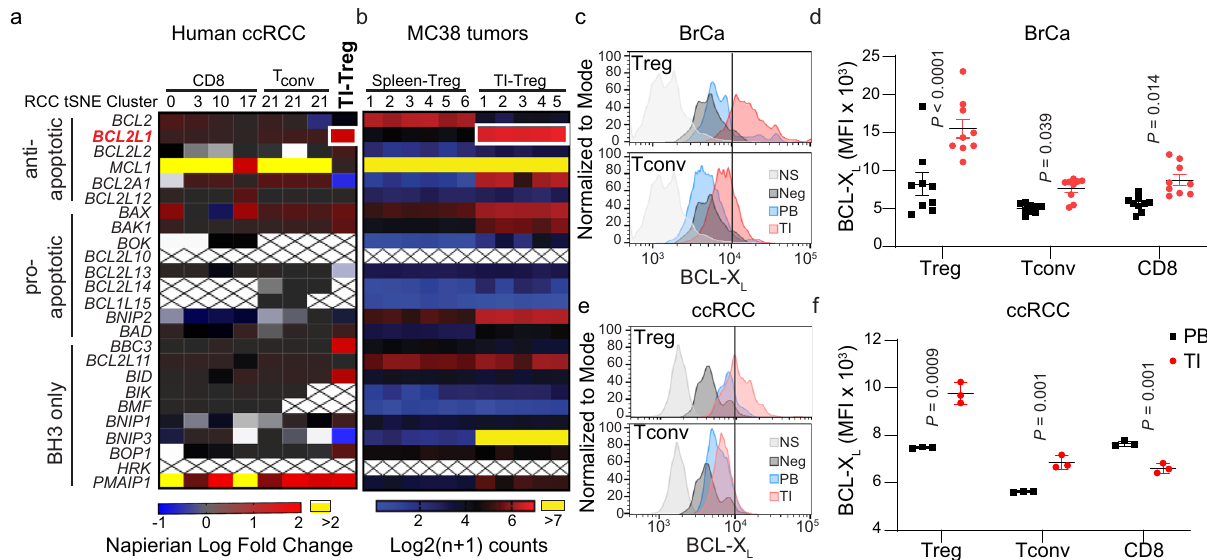
Fig. 1 BCL-X L is selectively upregulated in TI-Tregs. a Heatmap depicting the fold difference in expression of members of the BCL-2 gene family from distinct subsets of TI-T cells relative to T cell counterparts from peripheral bloods (PB) of paired RCC patients. TI-T cells include CD8 + , conventional CD4 + (Tconv), and TI-Tregs. See Supplementary Fig. 1a for characterization of immune cell clusters by tSNE plot of scRNAseq data. Cross-hatching indicates no expression. b Heatmap depicting the expression of BCL-2 family genes in mouse MC38 colon adenocarcinoma TI-Tregs and splenic Tregs. c Representative histogram showing BCL-X L levels in PB- and TI-Tregs or TI-Tconv from human breast cancer (BrCa), and d median fl uorescence intensity (MFI) of BCL-X L staining ± s.d. in PB- or TI-Tregs, CD8 + , and Tconv in these cancers ( n = 9 biological replicates). e Representative histogram showing BCL-X L levels in PB- and TI-Tregs or TI- Tconv from human renal cancer and paired blood, and f MFI of BCL-X L staining ± s.d. in PB- or TI-Tregs, CD8 + , and Tconv in these cancers ( n = 3). Unpaired T - tests ( d , n = 9; and f , n = 3 biological replicates, two-sided) were performed and the corresponding P values are indicated. c , e NS, non-staining; Neg, negative control, treated with DT-2216 to deplete BCL-X L as negative different populations of effector/memory phenotypes (Supplemen- tary Figs. 2b and 3e, f), all of which exhibited lower expression of BCL-X L relative to TI-Tregs (Supplementary Fig. 3g, h). The selective upregulation of BCL-X L in TI-Tregs, as well as high levels of the pro-apoptotic BH3 − only proteins NOXA (encoded by PMAIP1 ), BID and BAX (Fig. 1a), which inhibit MCL-1 and BCL- 2 respectively, suggest that TI-Tregs may primarily depend on BCL-X L for survival 24 .